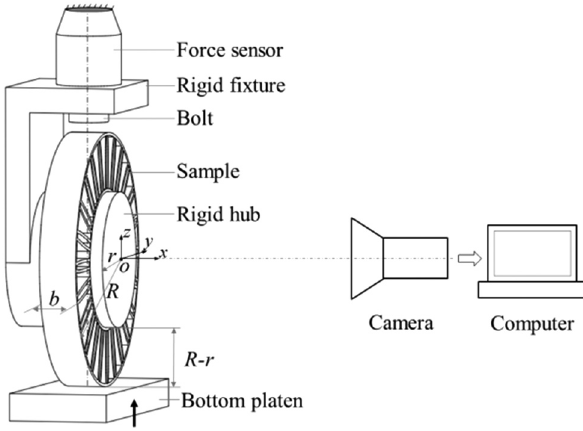
Figure 3: Diagram of quasi - static uniaxial compression experiment.